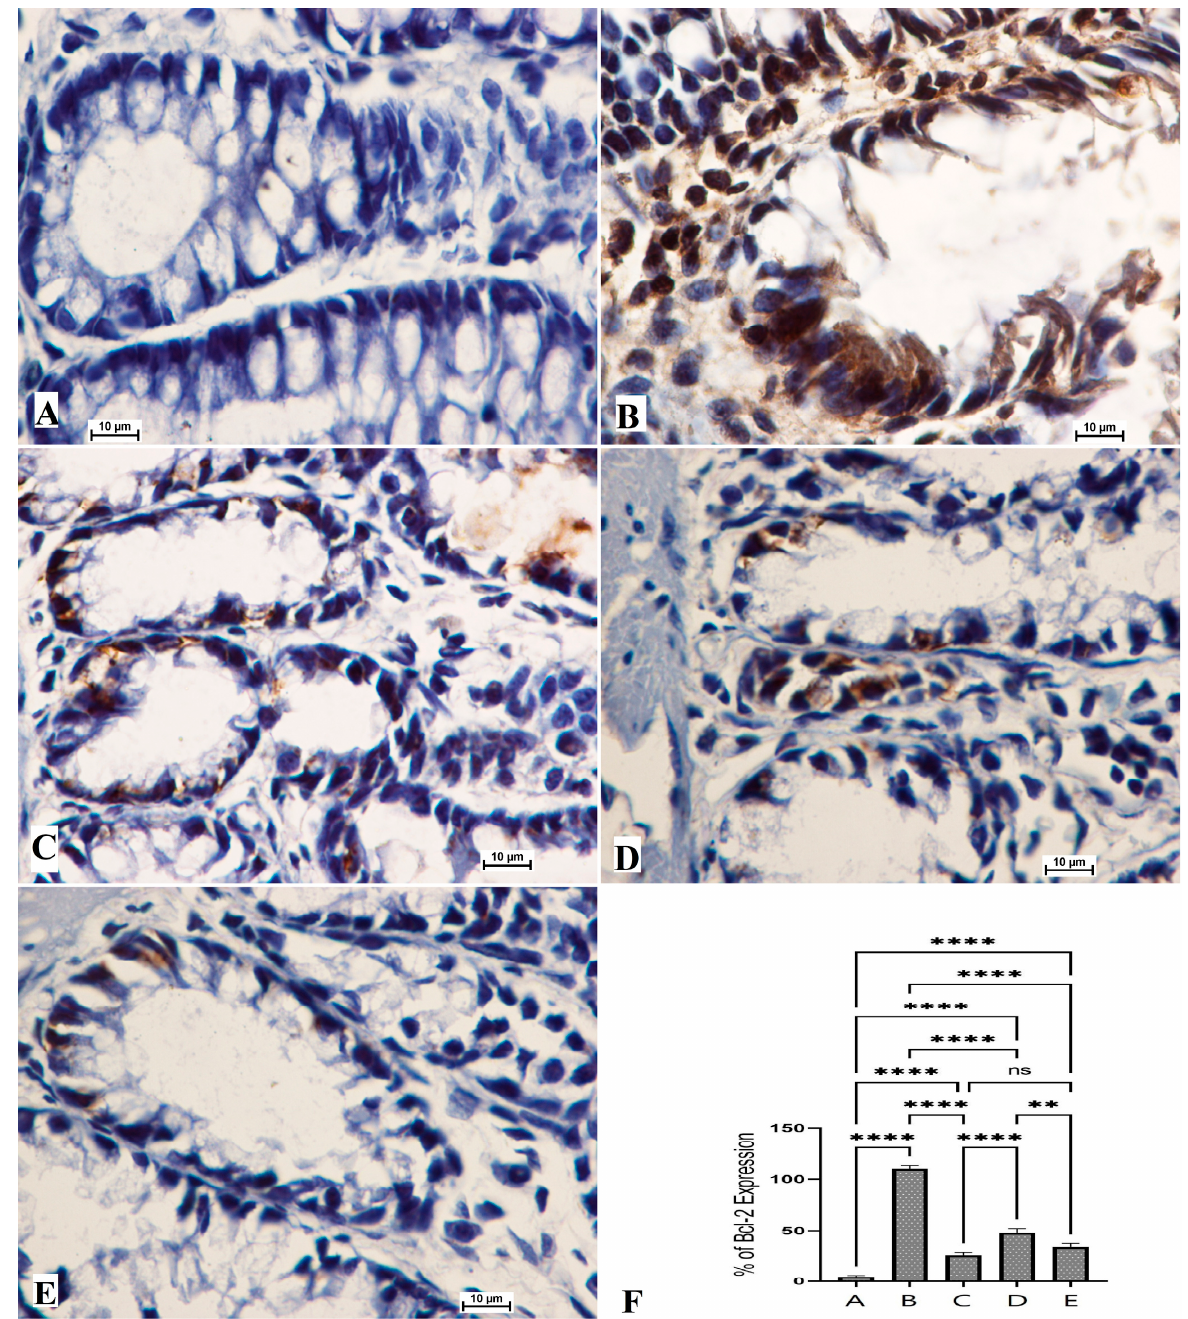
Figure 6. Histological views of colon tissue according to the Bcl-2 protein expression ( A – E ) and quantitative statistics ( F ) of Bcl-2 protein expression on colon tissue in induced foci in rats. Normal control rats ( A ) had normal colonic mucosa and very weak expression of Bcl-2 protein ( F ). Colon cancer rats ( B ) had severe lesions in the mucosa and increased expression of Bcl-2 protein ( F ). Reference rats (5-Fu) ( C ) had mild mucosal colon tissue lesions and lower Bcl-2 protein expression ( F ). Rats treated with 200 mg/kg of OME ( D ) had moderate tissue damage and low Bcl-2 protein expression ( F ). Rats addressed with 400 mg/kg OME ( E ) had mild mucosal lesions of colon tissue and lower Bcl-2 protein expression compared to cancer controls ( F ). (Bcl-2 stain, magnification 100 × ). Values are shown as means ± SEM. ns, non-significant; **, means significant at p < 0.01; ****, means significant at p < 0.0001.